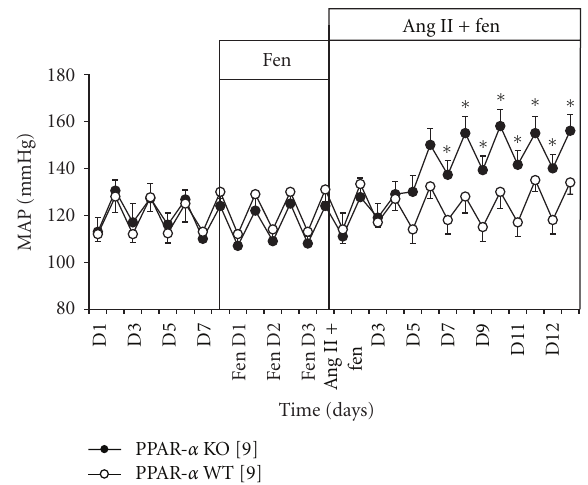
Figure 2: Mean arterial pressure of PPAR- α KO mice [18] ( • ) and PPAR- α WT mice [9] (o) during control days 1–7, days 1– 3 of fenofibrate treatment, and days 1–12 of Ang II + fenofibrate treatment. MAP was significantly higher in KO + Ang II + Fen versus WT + Ang II + Fen ( ∗ P < 0 .